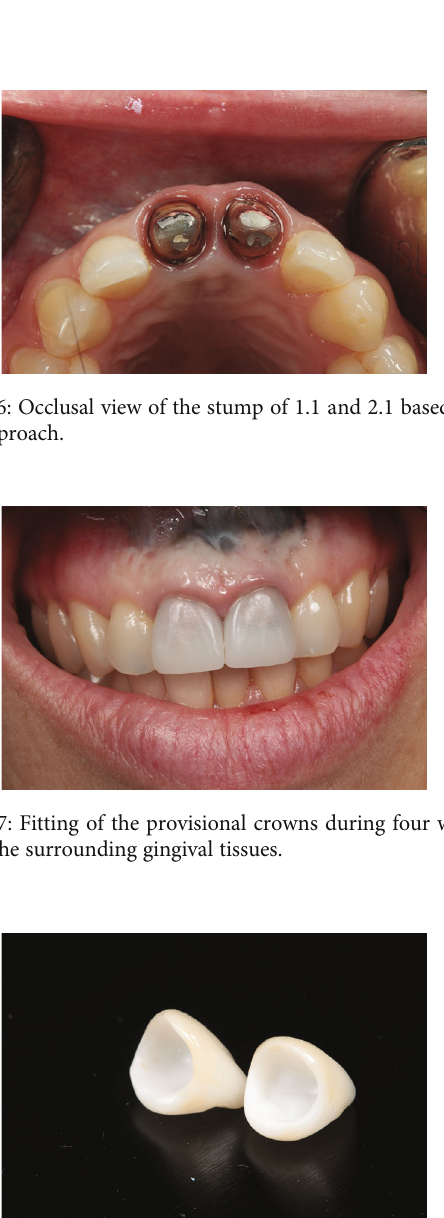
Figure 28: The de fi nitive crowns made of monolithic zirconia with strati fi ed feldspathic porcelain on the buccal aspect.